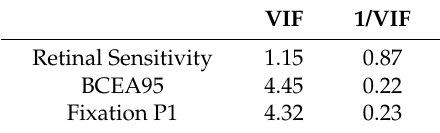
Figure 4. Comparison of two prediction models for MCI versus normal cognition, one based on retinal sensitivity and fixation parameters P1 and BCEA95, and one with retinal sensitivity alone. Table 5. Multicollinearity assessment: Variance inflation factor (VIF) for each